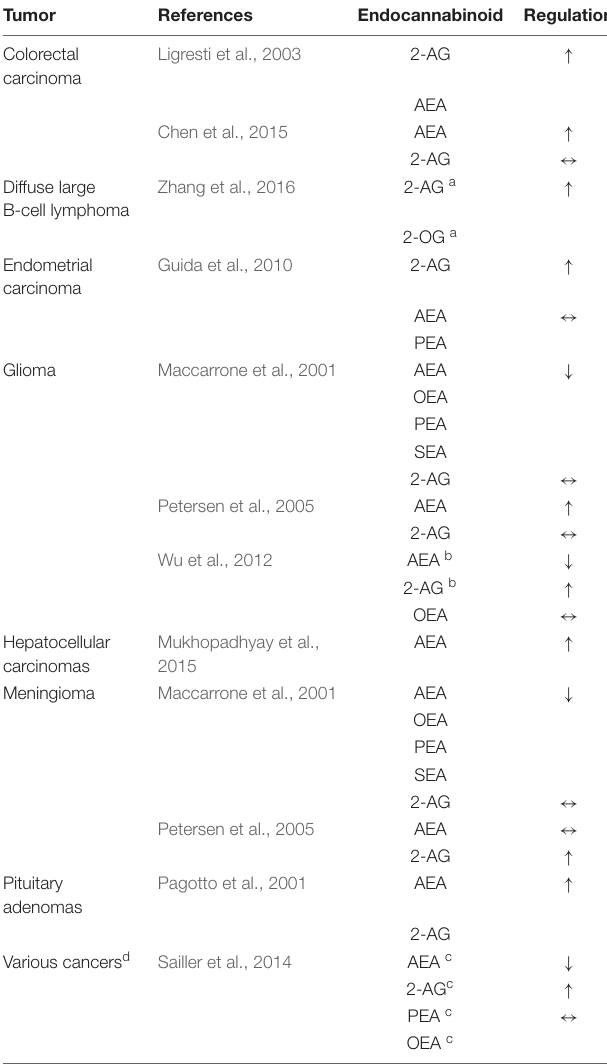
TABLE 1 | Regulation of endocannabinoids and endocannabinoid-like substances in cancer